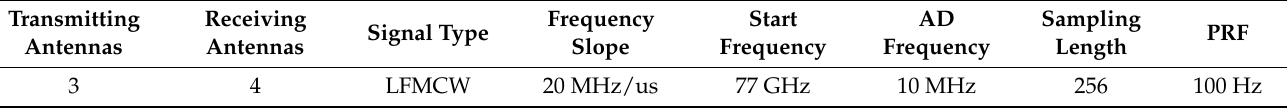
Table 2. Parameters for simulations and